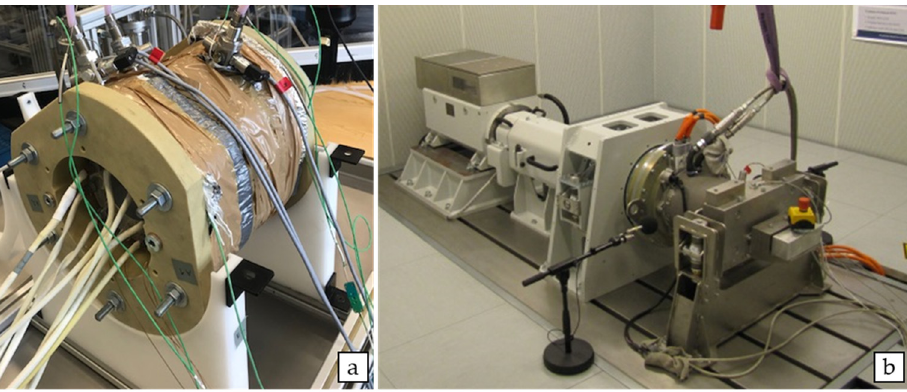
Figure 5. Stator cooling jacket test bench ( a ) and electrical machine test bench ( b ).